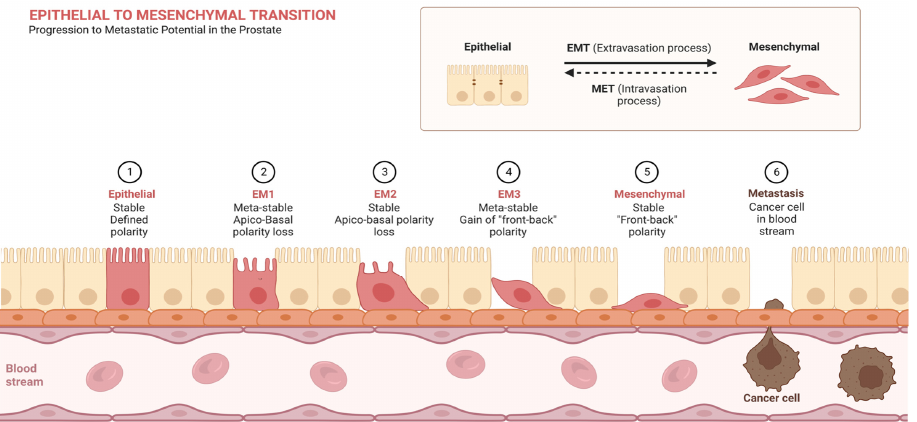
Figure 1. Mechanism of action of EMT in the prostate cell. The progression to metastatic cancer involves the loss of stable apico-basal epithelial cell polarity, the gain of front–back polarity, and eventual metastasis to the bloodstream. Created with BioRender.com (11 March 2023).